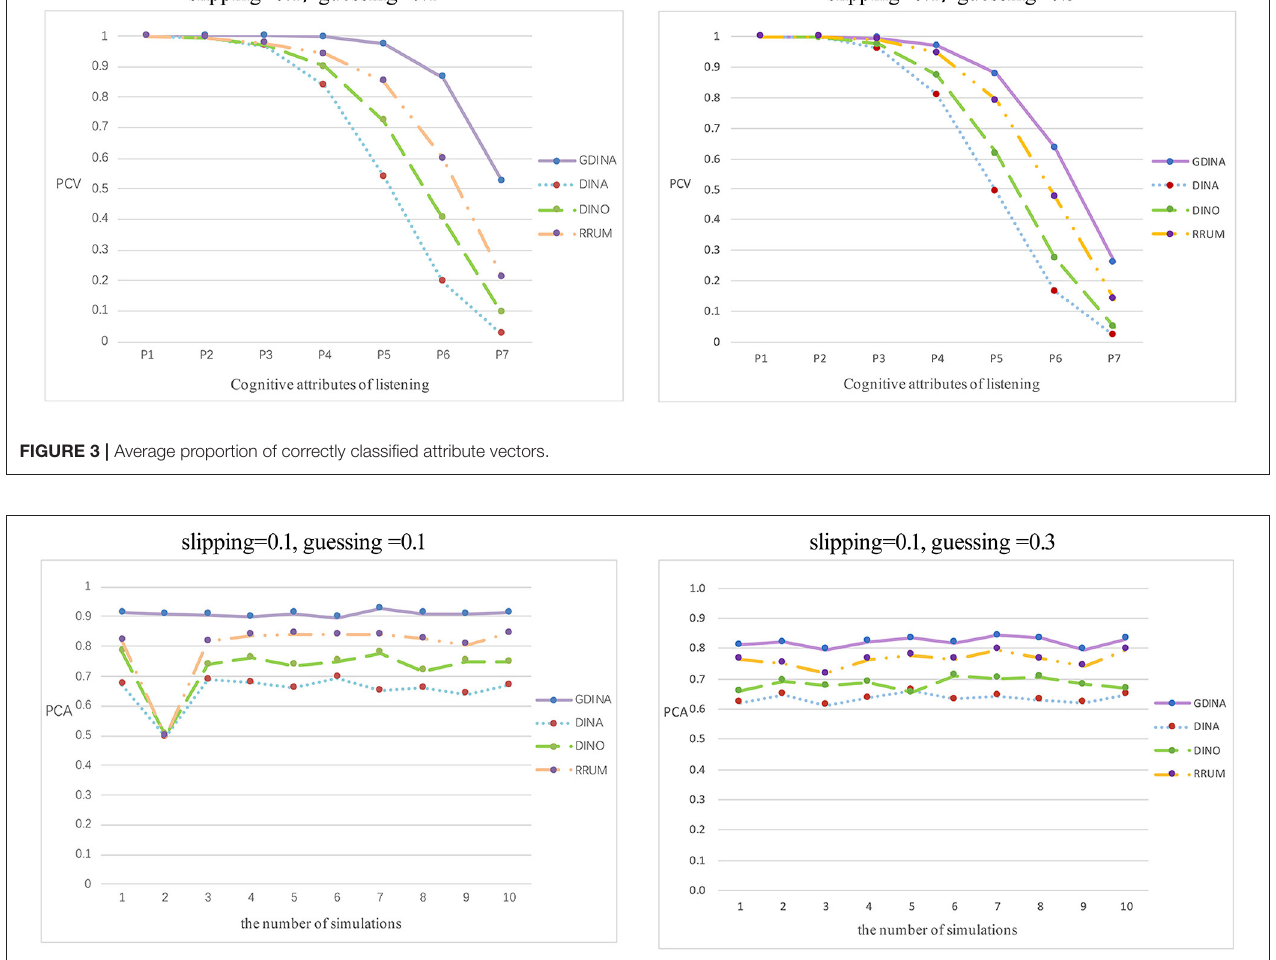
FIGURE 4 | Classification accuracy rate of attribute